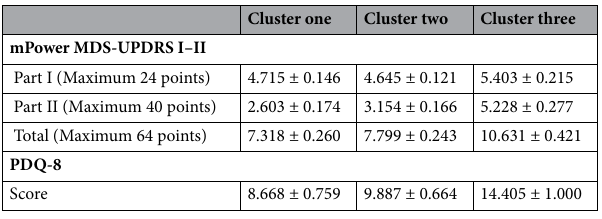
Table 1. Scores from the mPower MDS-UPDRS I–II and PDQ-8 for the three clusters.